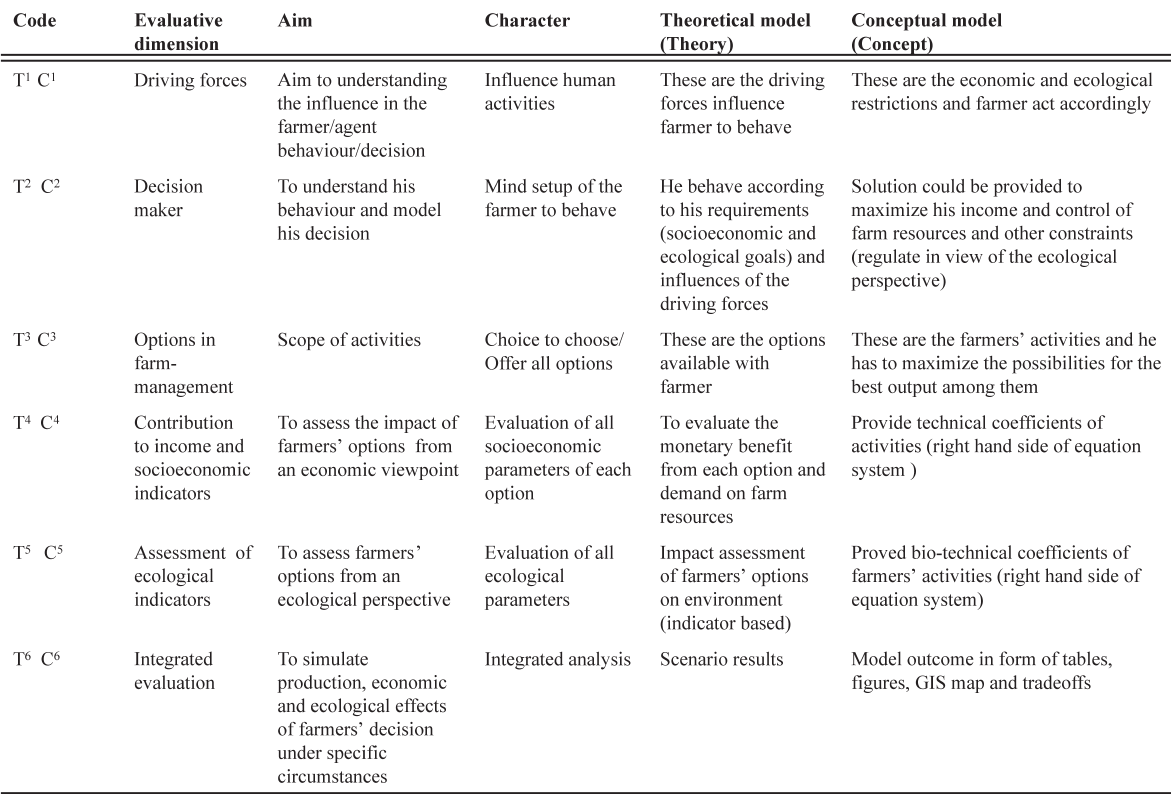
Table 2. synthetic vision of theoretical and conceptual models developed for the mountains of the Indian Himalayan region (Code ‘T’ for Theoretical model and ‘C’ for Conceptual model). T 1 , T 2 , T 3 … T 6 : Modules of theoretical model development as described in Fig. 7; C 1 , C 2 , C 3 … C 6 : Modules of conceptual model development as described in Fig.